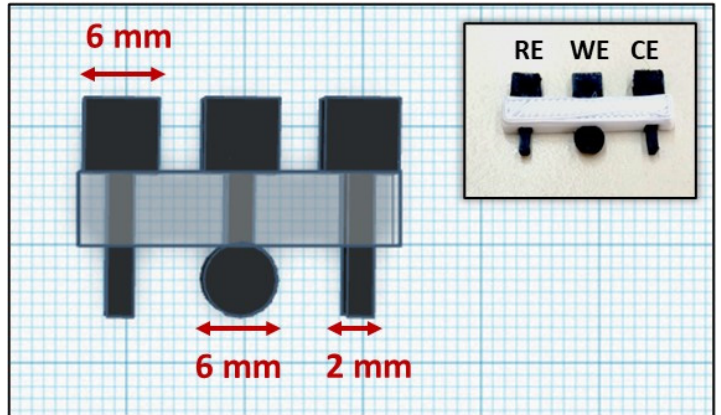
Figure 1. Schematic illustration and photograph of the 3D-printed